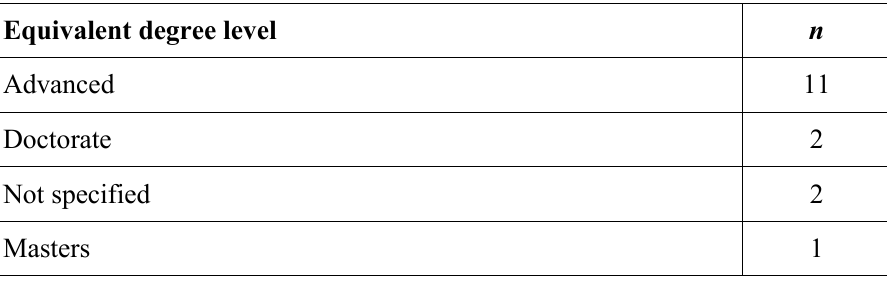
Table 2 : Level of equivalent degree required ( n = 16); synonyms for advanced were graduate and professional; a synonym for doctorate was terminal.